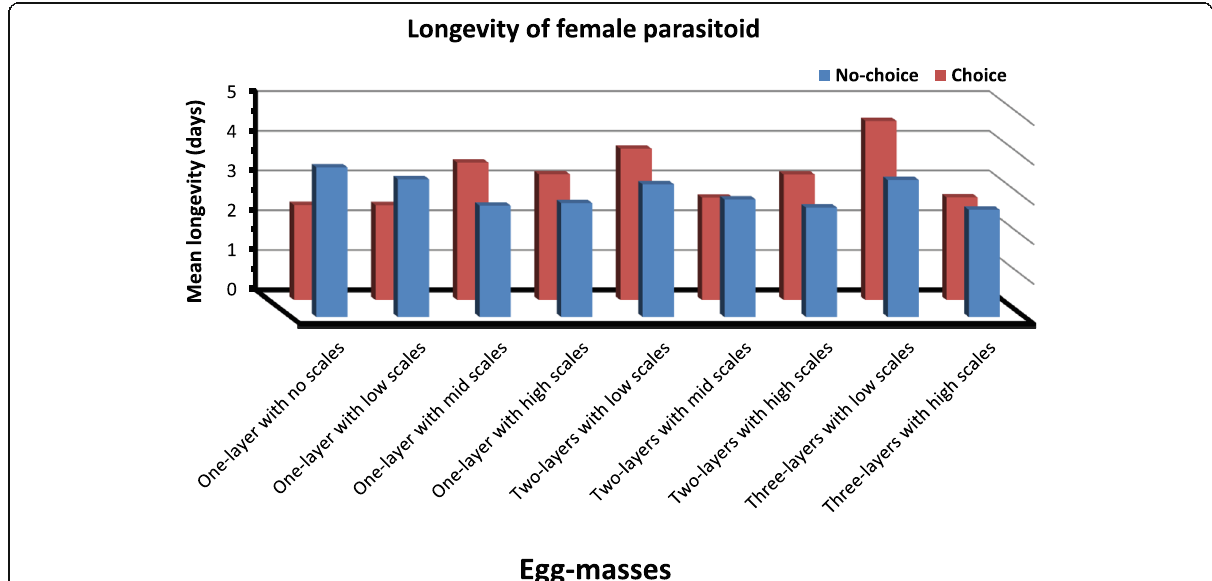
Fig. 3 Mean longevity (days) of female T. bactrae adults emerged from S. littoralis egg masses with different physical characteristics in a no- choice and choice tests. No significant differences were found between both